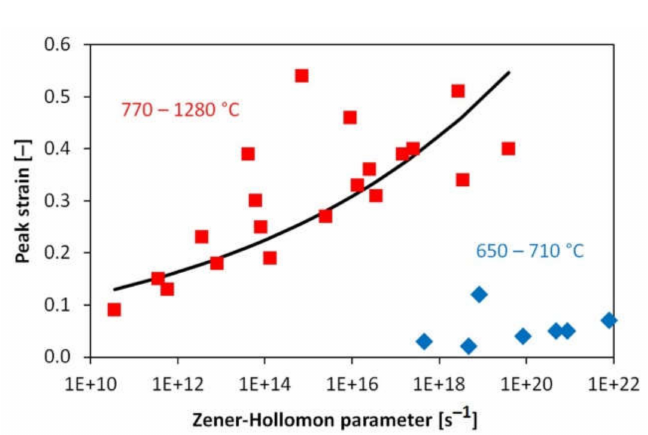
Figure 18. Experimental values of e p (coloured points) and their mathematical description in the high-temperature region by Equation (7) (black line).